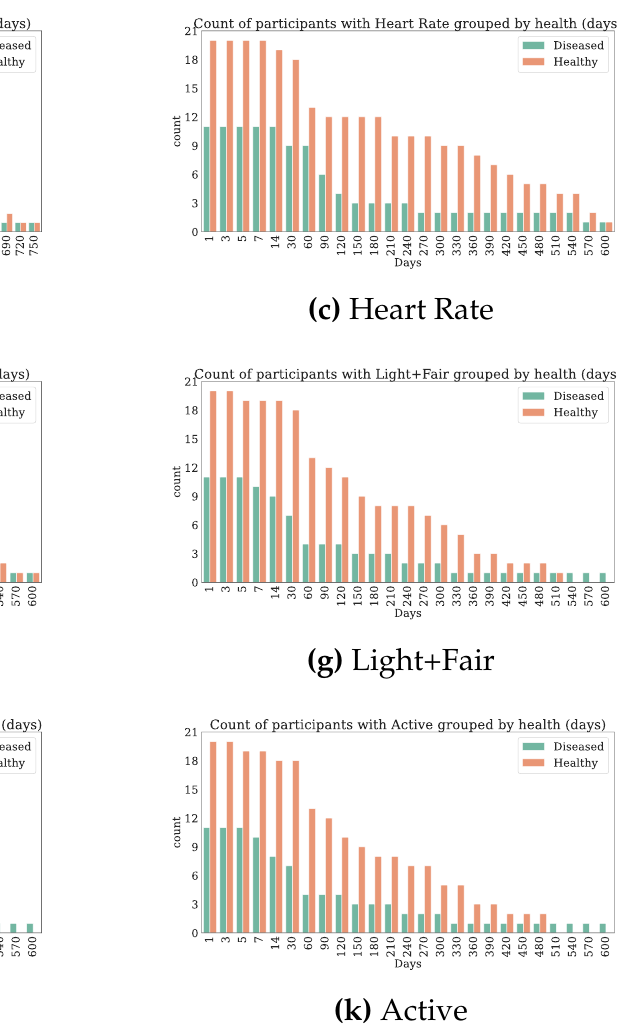
Figure A13. Count of seniors with at least the given valid days of Fitbit (TechRO) by outcome and health group